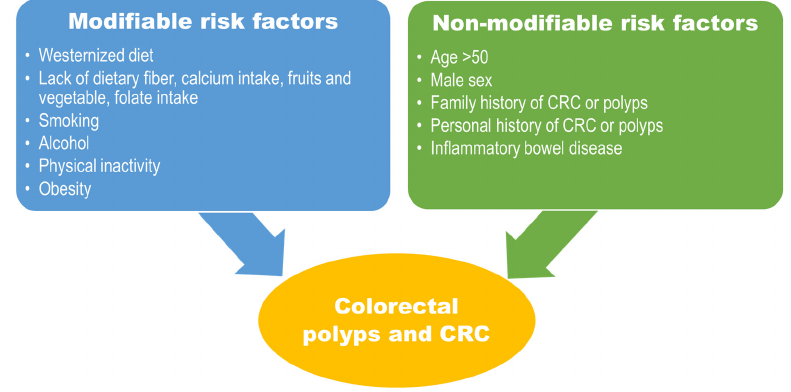
Figure 3. Risk factors can be categorized as modifiable and nonmodifiable.